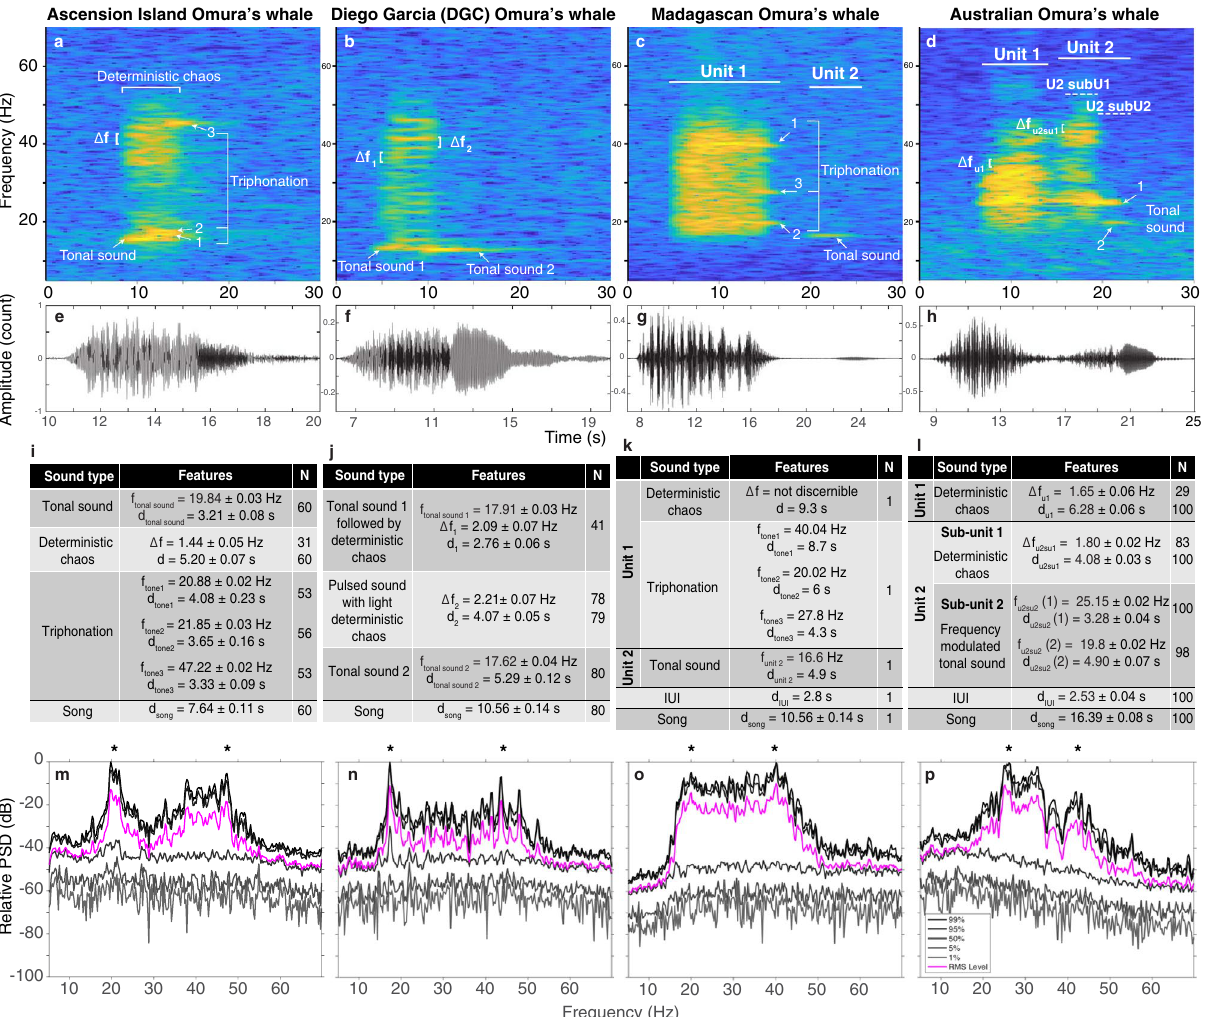
Figure 6. Spectrograms ( a – d ), waveforms ( e – h ), acoustic measurements (mean ± (s.e.)— i – l ), and Power Spectral Density (PSD— m – p ) of the songs of the Omura’s whales from Ascension Island, Madagascar, Diego Garcia and Australia. The stars on the PSD ( m – p ) outline the peaks of energy. The Ascension Island song was recorded off Ascension Island (CTBTO records, site H10N1) in November 2005, the Madagascar song was recorded off Madagascar in December 2015 and provided by S. Cerchio, the Diego Garcia DGC song was recorded at DGN (CTBTO records, site H08N1) in October 2003 and the Australian song was recorded at Kimberley site in March 2013 (IMOS records). For the panels ( a – d ) and ( i – j ): N is the number of measurements, u i su j stands for unit i subunit j where i and j are the unit and subunit numbers, (cid:31) f designates the frequency difference between the sidebands, f and d are the frequency and duration of the feature indicated in subscript, and when present, the number in brackets refers to the point measured as indicated on the corresponding spectrogram. (Spectrogram parameters: Hamming window, 1024-point FFT length, 90% overlap. Note that the axes differ among